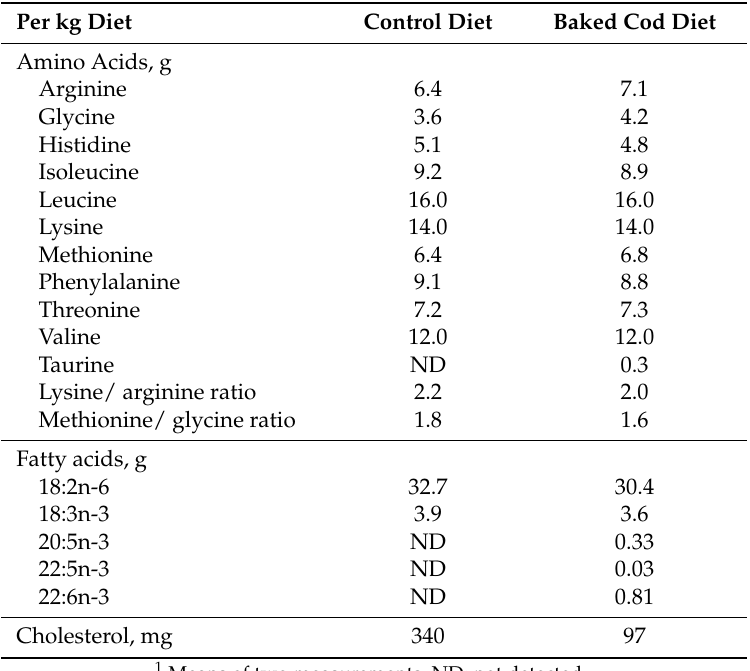
Table 2. Contents of indispensable amino acids, the functional amino acid glycine, the conditionally essential amino acid arginine, taurine, the ratios of lysine/arginine and methionine/glycine, essential fatty acids and long-chain polyunsaturated fatty acids in the diets 1.